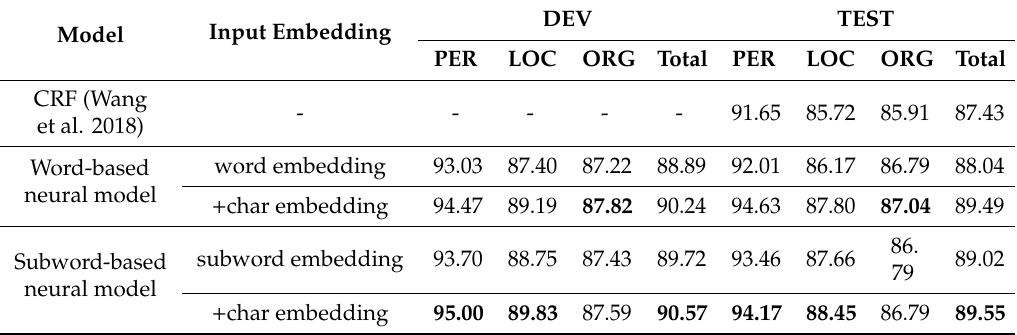
Table 4. Comparison of performance on di ff erent neural models (%). Bold indicates the best result in below models for each entity